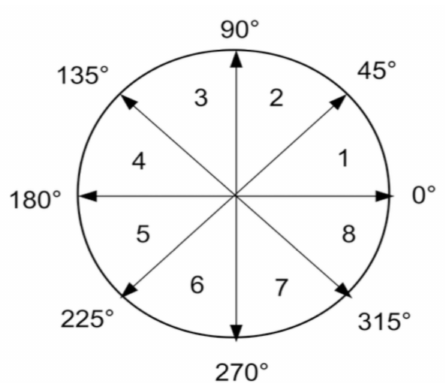
Figure 8. The eight directions. Angles between 0 ◦ and 45 ◦ fall into the direction